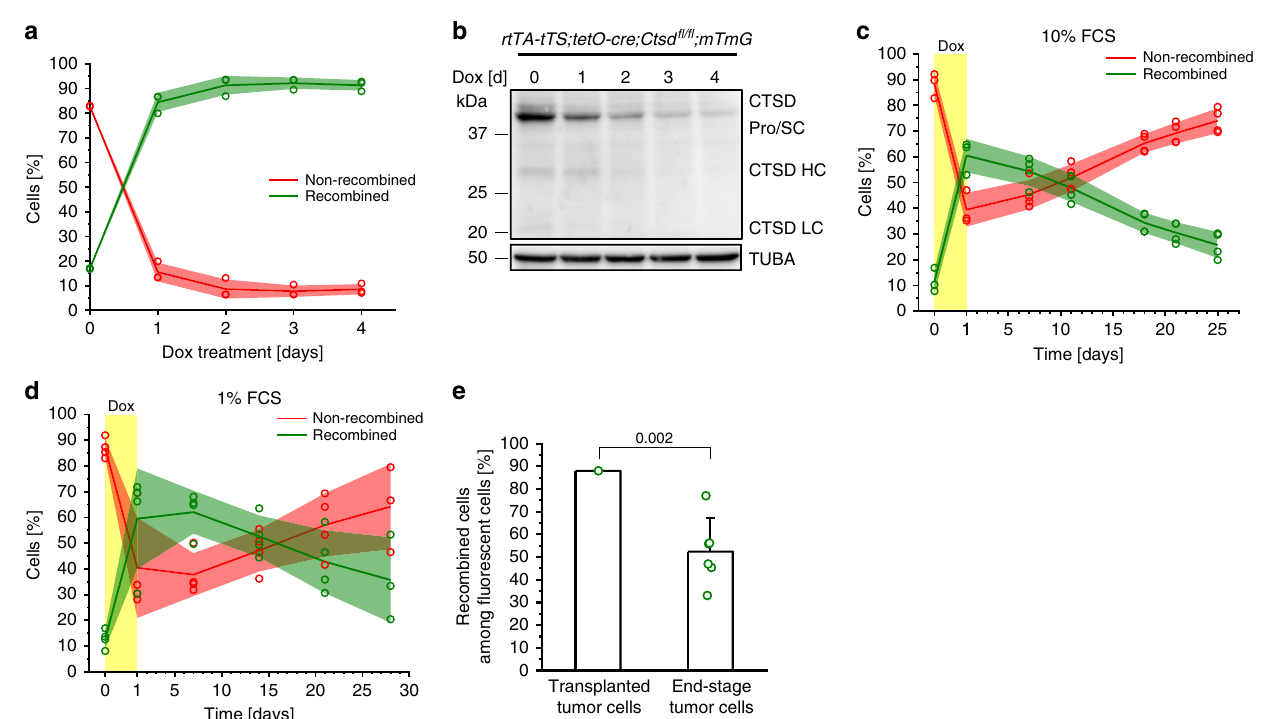
Fig. 2 Tumor cell-autonomous growth de fi cit through CTSD deletion. a Flow cytometry-based monitoring of cre recombination reporter